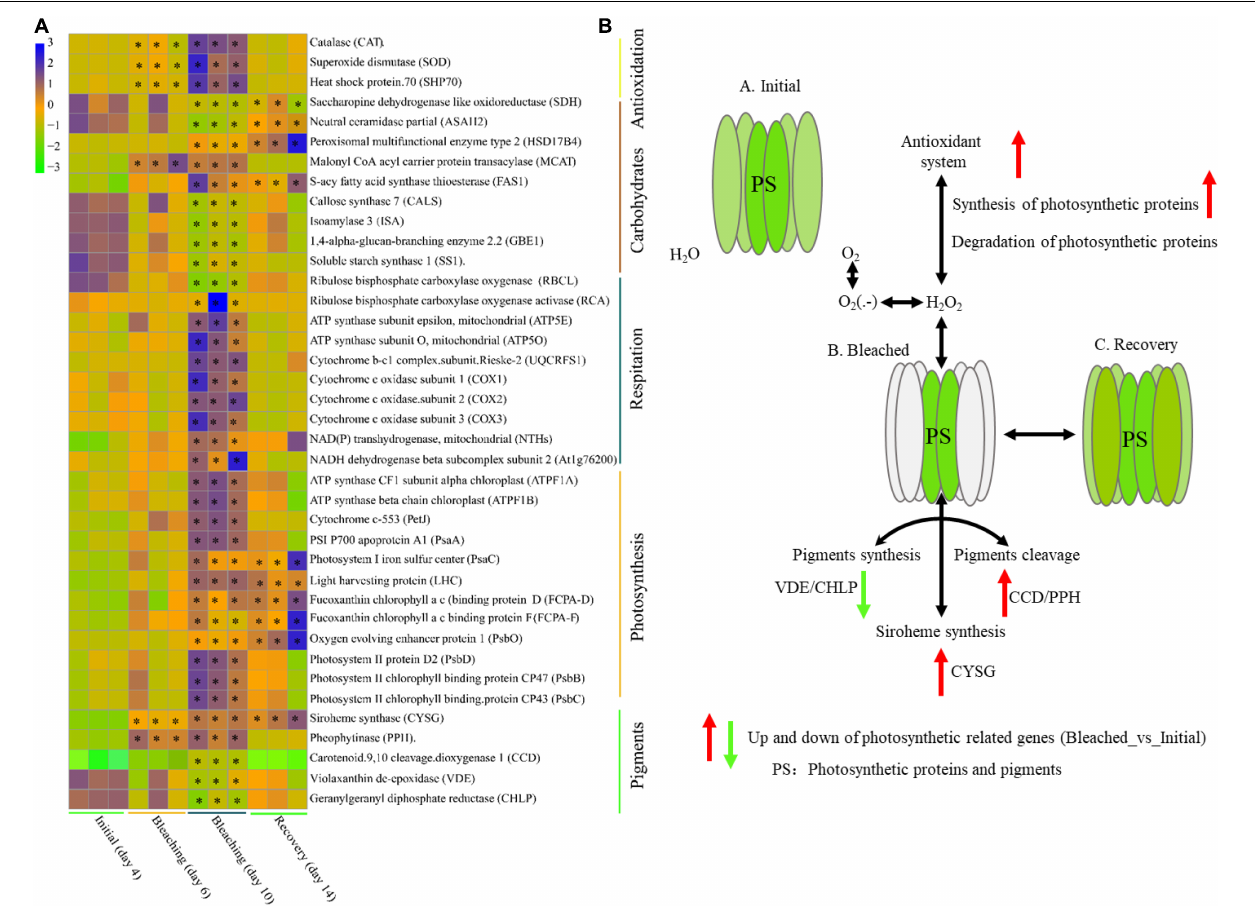
FIGURE 4 | Differential transcription of photosynthesis-related genes during the bleaching and recovery experiment. (A) Pheatmap of differentially transcribed genes involved in pigment metabolism, photosynthesis, respiration, carbohydrate metabolism and antioxidant activity. (B) Scheme illustrating the effect of thermal stress on the photobleaching and recovery of E. voratum SCS01 cells. The pheatmap was drawn based on the FPKM values of differentially transcribed genes on day 4 (26 ◦ C, initial period), day 6 (32 ◦ C, bleached period), day 10 (32 ◦ C, bleached period), and day 12 (26 ◦ C, recovery period). Stars indicate significantly transcribed genes in the bleached period or recovery period vs. the initial period ( q -value <